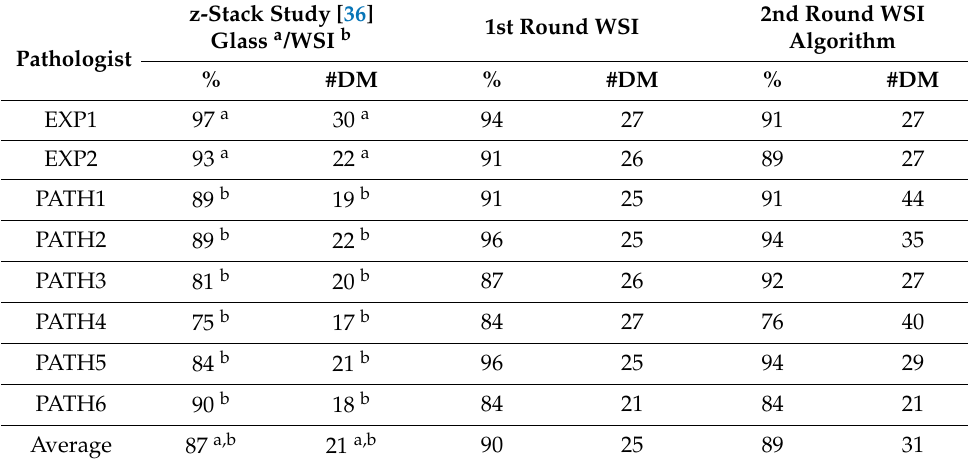
Table 1. Concordance as a percentage (%) of cases identical with the consensus diagnosis based on glass slides for all cases excluding nevoid melanoma ( n = 89) and number of cases with reported dermal mitosis (#DM) concerning intermediate lesions and melanoma (excl. nevoid melanoma) ( n = 54). a Glass; b WSI.